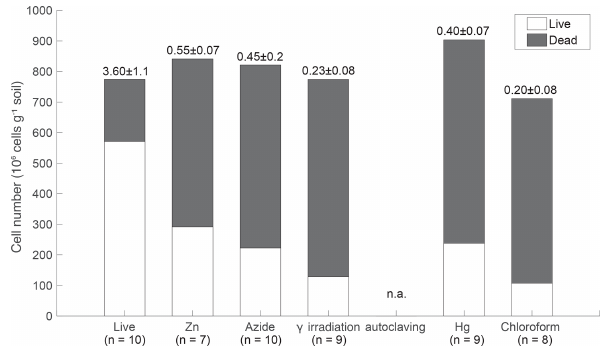
Figure 1. Live and dead microbial cell counts of tropical peatland soils. The numbers above the bars indicate the live to dead sig- nal ratio ± SD. No detectable signal was observed in autoclaved samples. The x axis represents treatments (live: no treatment; Zn: ZnCl 2 ; Hg: HgCl 2 ; Azide: NaN 3